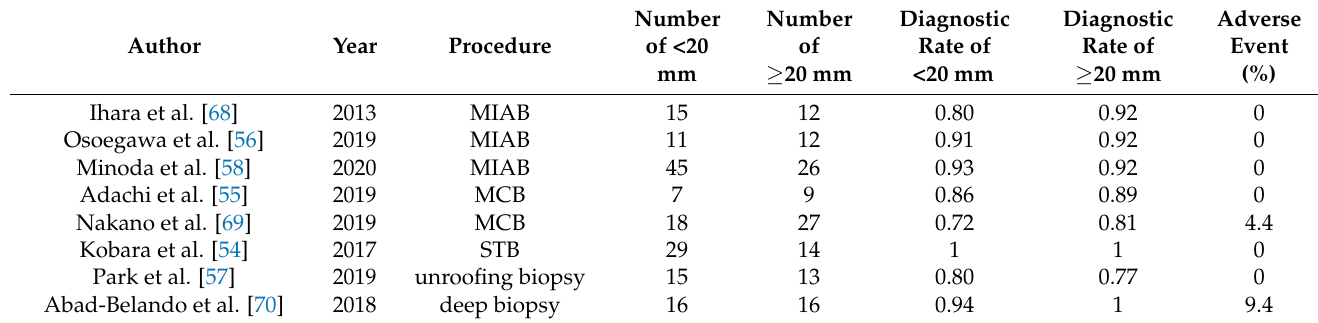
Table 2. Details of studies on various biopsy